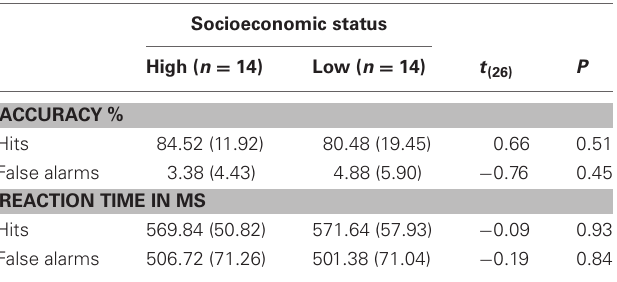
Note: Values represent group means (values in parentheses represent standard deviations) collapsed across tone frequency conditions which did not reveal sig- nificant differences on preliminary analyses. Accuracy is in percentage; reaction times are in